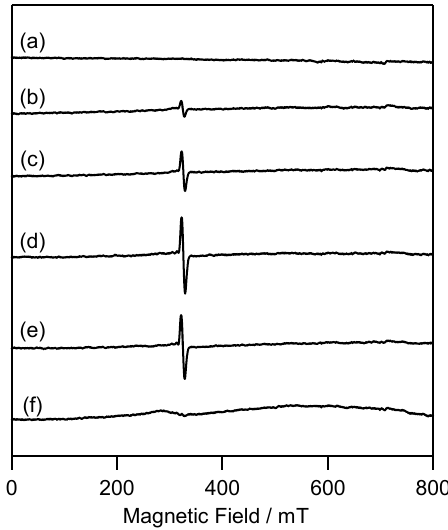
Figure 1. ( a ) ESR spectrum obtained by irradiation ( λ > 350 nm) of diazo compound 1a -N 2 in 2-methyltetrahydrofuran at 77 K; ( b – e ) The same sample measured at 77 K after thawing to 200 K ( b ), 220 K ( c ), 230 K ( d ), and 300 K ( e ); ( f ) The same sample measured at 77 K after exposure to air.